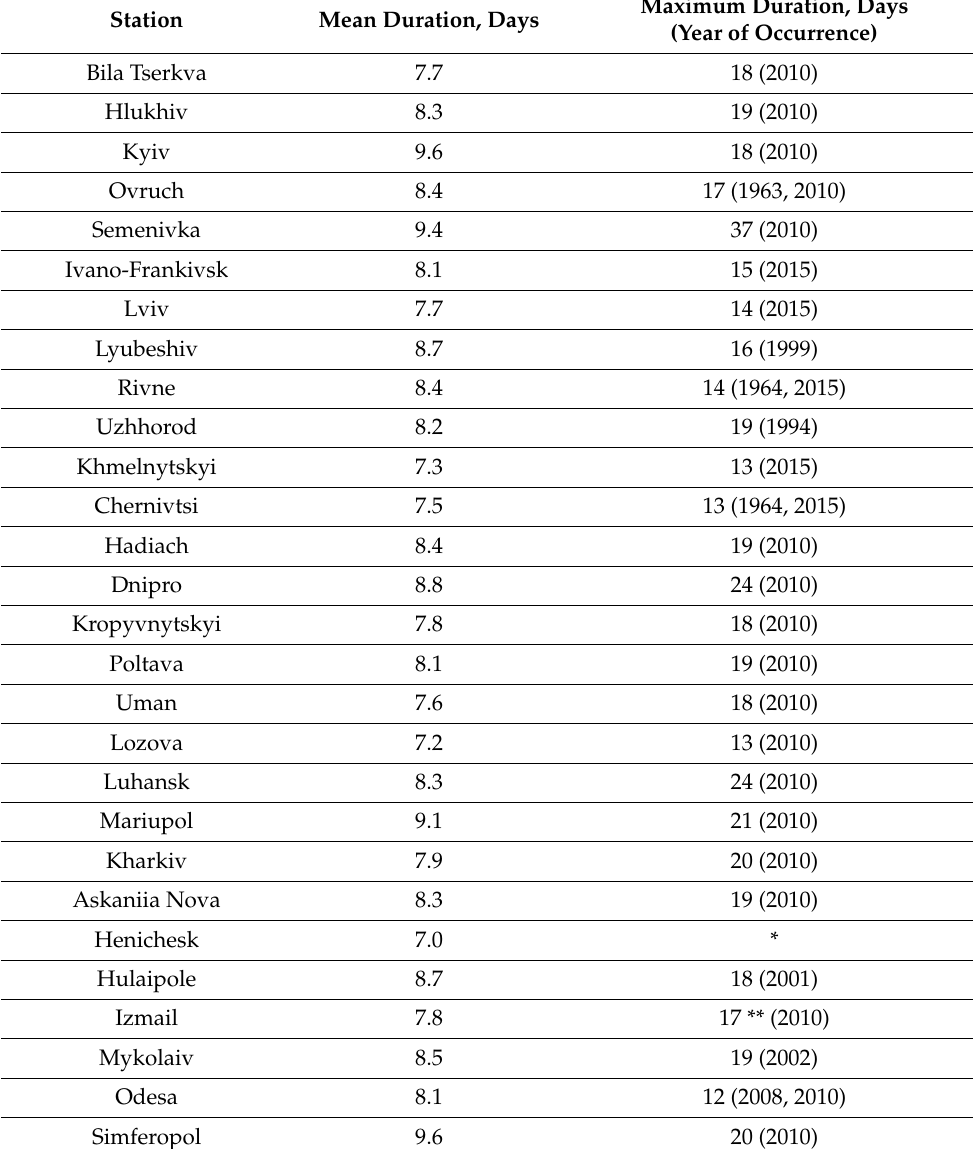
Table 2. Duration HWs in Ukraine in the years